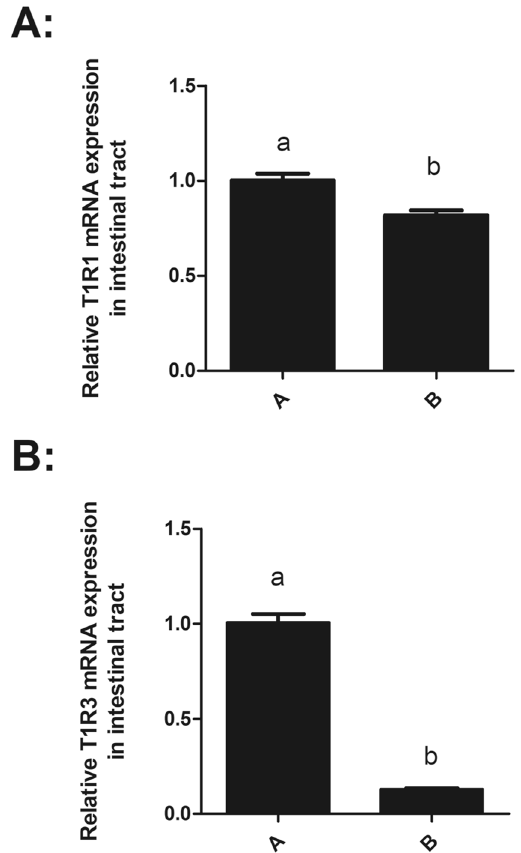
Figure 8. The T1R1 and T1R3 mRNA expression levels of the intestinal tract in the grass carp transition from carnivory to herbivory. ( A ) mRNA expression levels of T1R1 gene in the intestinal tract of grass carp transition from carnivory to herbivory. ( B ) mRNA expression levels of T1R1 gene in the intestinal tract of grass carp transition from carnivory to herbivory. The T1R1 and T1R3 gene expression levels were both significantly reduced in the grass carp brain and intestinal tract after the food habit transition to herbivory. All values represented the mean ± S.E.M. (n =